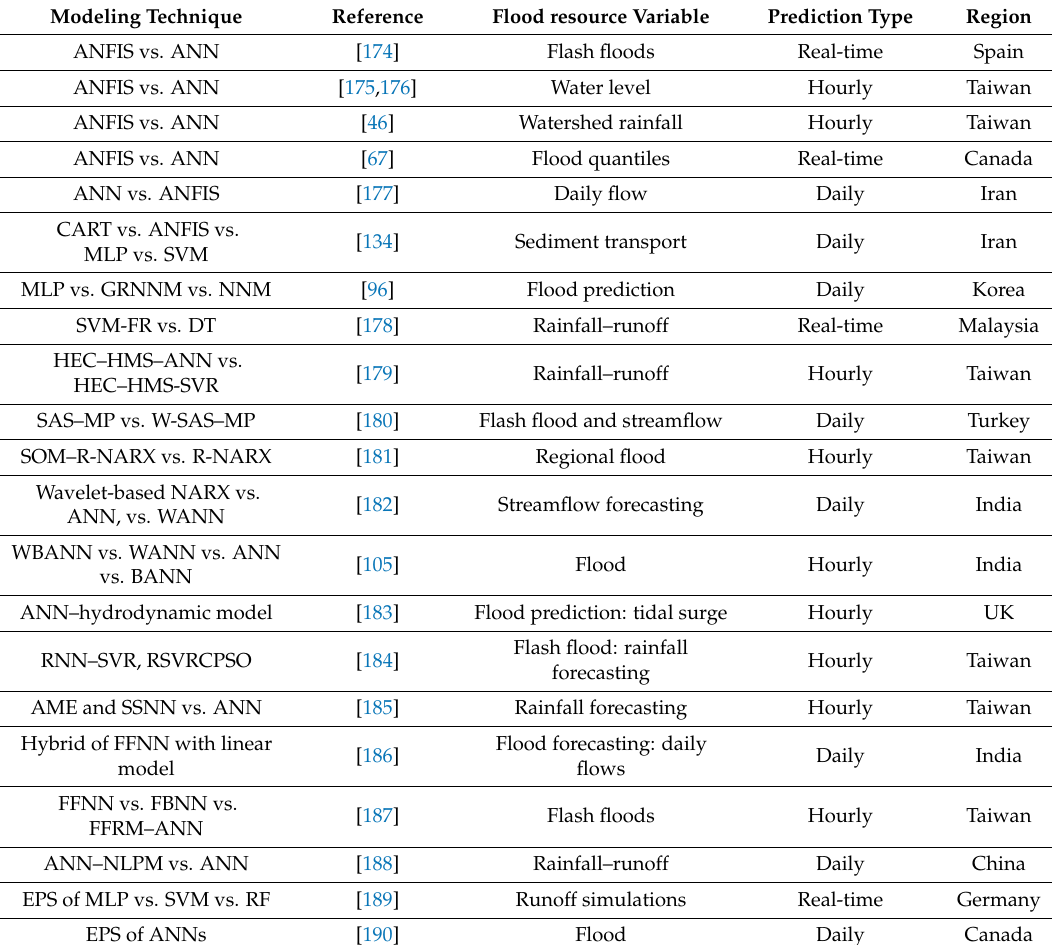
Table 3. Short-term flood prediction using hybrid ML